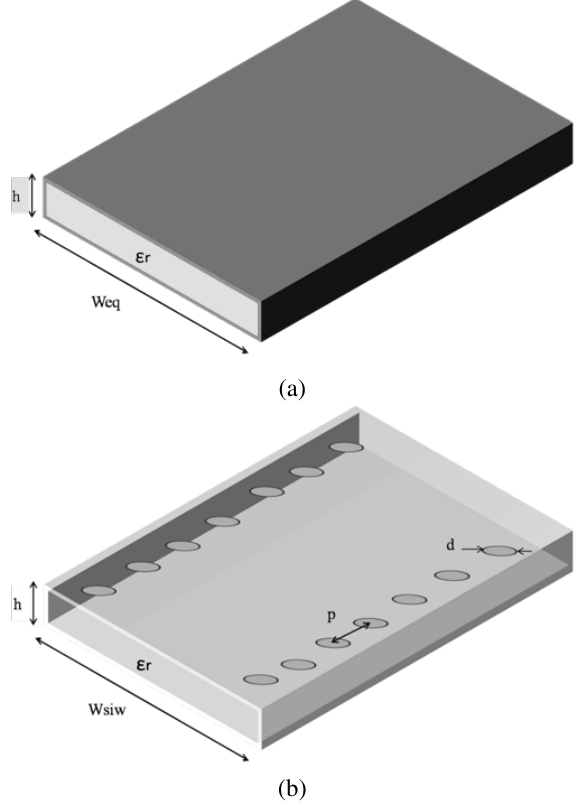
Figure 1: Structural parameters of: (a) An equivalent rect- angular waveguide. (b) A substrate integrated